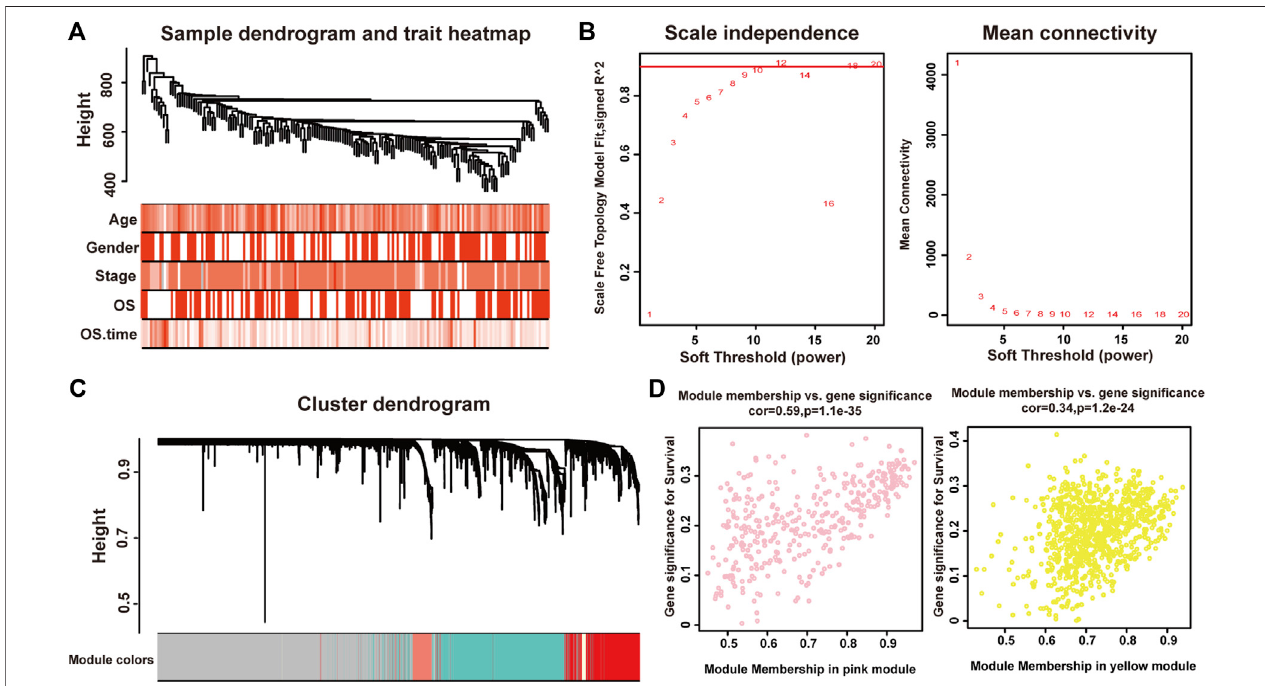
FIGURE 1 | Identi fi cation of modules associated with the clinical traits of pancreatic adenocarcinoma. (A) Clustering dendrogram of 175 samples. (B) The relationship between soft threshold (power) and network properties. Left panel: The relationship between soft-threshold (power) and scale-free topology. Right panel: The relationship between soft threshold (power) and mean connectivity. We set the soft threshold (power) to be twelve to satisfy scale-free topology of the network. (C) Total genes were clustered in 22 modules. Each module was marked with one color. (D) A scatterplot of Gene Signi fi cance (GS) for disease vs. Module Membership (MM) in the pink (left panel) and yellow (right panel) modules.